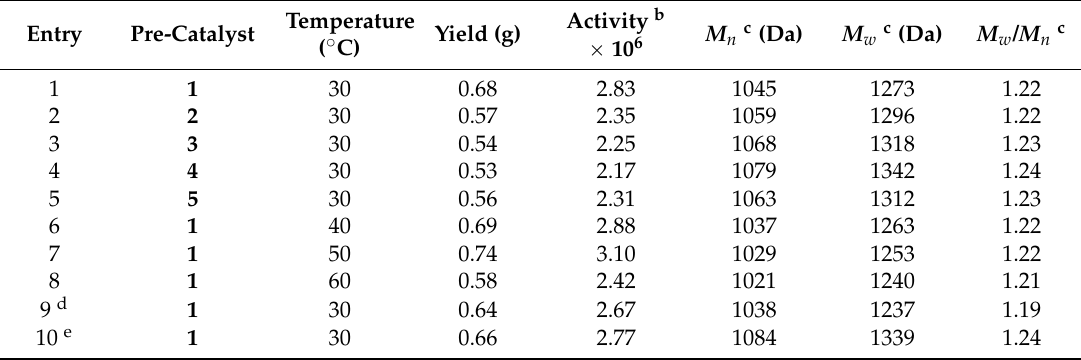
Table 1. Polymerisation of 1-hexene using salicylaldimine-iron(III) pre-catalysts 1 – 5 and EtAlCl 2 as cocatalyst a